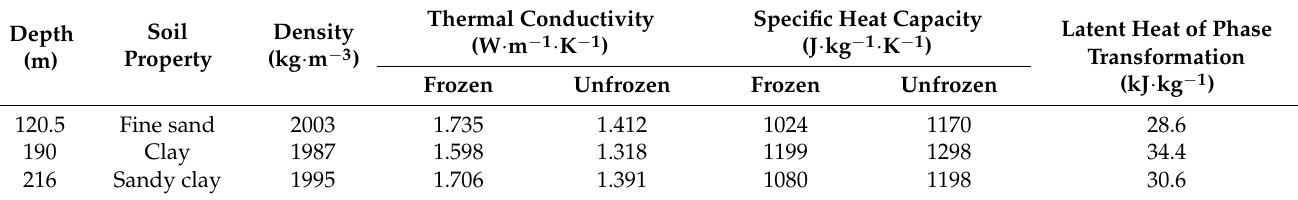
Table 2. Thermophysical parameters of soil.